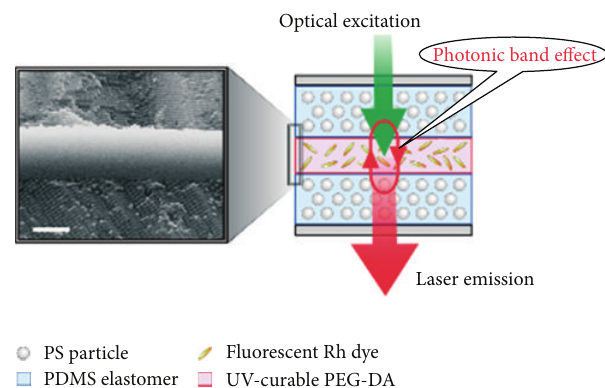
Figure 17: A schematic illustration of the colloidal crystal laser (CCL) proposed by Furumi et al. A light-emitting planar defect of Rhodamine (Rh)/PEG-DA is sandwiched between a pair of CC films of PS particles stabilized in PDMS elastomer. The left-hand picture represents a cross-sectional scanning electron microscopy (SEM) image of the magnified light-emitting planar defect between the PS/PDMS CC films. The white scale bar represents 2 𝜇 m [18].